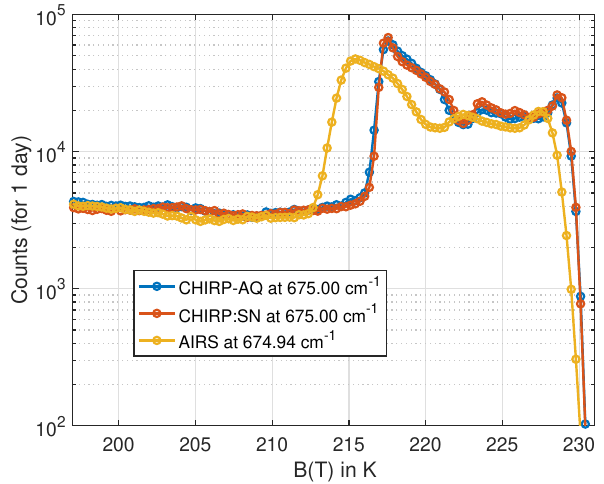
Figure 15. Histogram of 1-day’s worth of global BT observations for the (i) CHIRP-AQ channel at 675 cm − 1 , (ii) CHIRP-SN channel at 675 cm − 1 , and (iii) closest AIRS channel at 674.94 cm − 1 . For 1-day’s worth of data CHIRP:AQ will not necessarily be exactly the same as CHIRP-SN since they are in different orbits. However, note the high similarity between CHIRP-AQ and CHIRP-SN, especially in the high BT wing of the